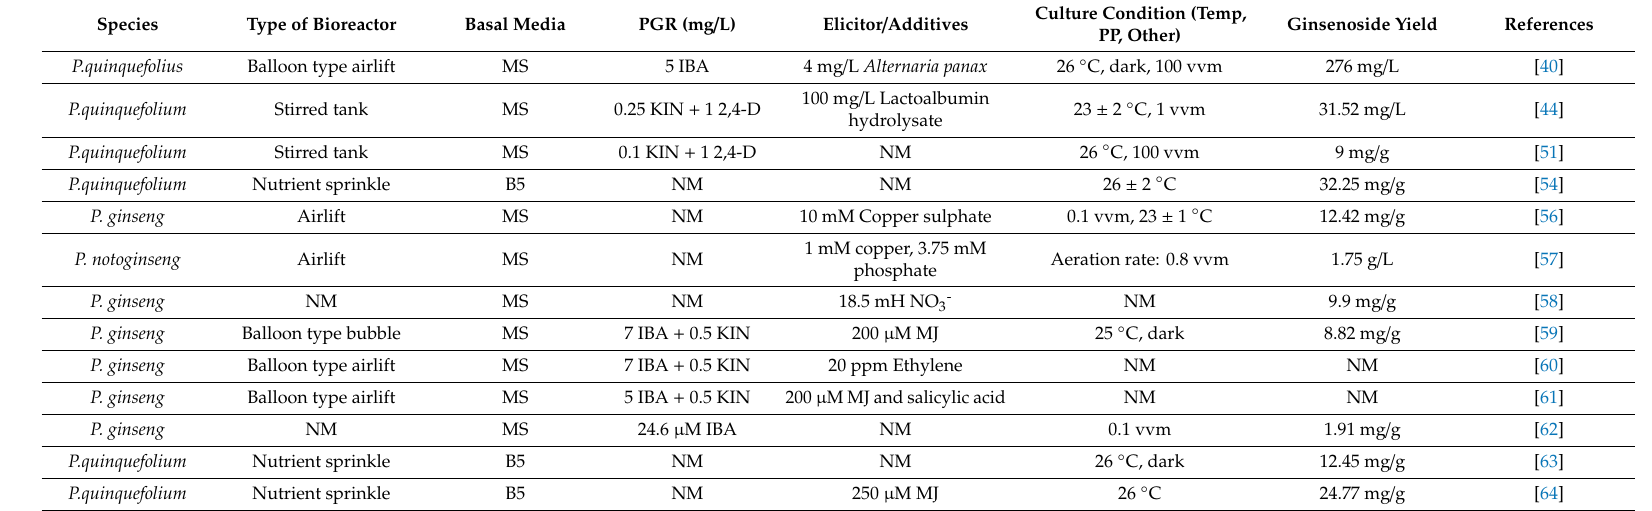
Table 3. Factors involved in and their influence on ginsenoside production during regeneration via bioreactors.